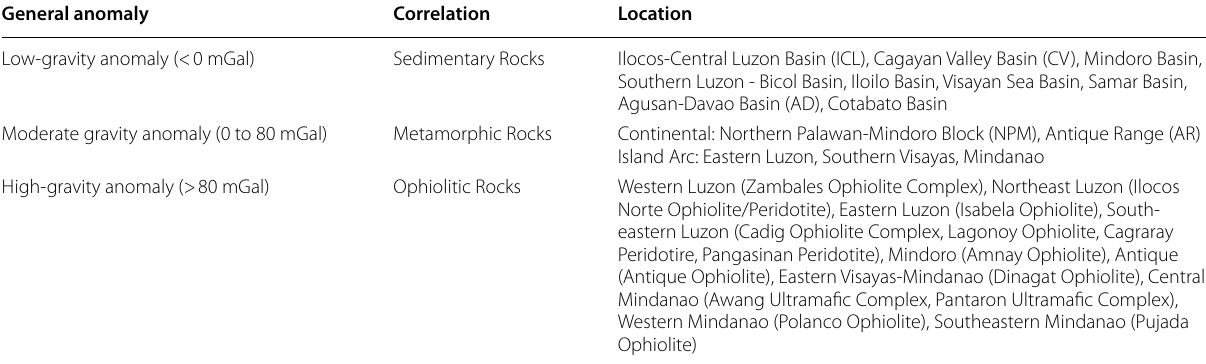
Table 1 Significant regional geologic features are delineated on the isostatic anomaly map of the Philippines General